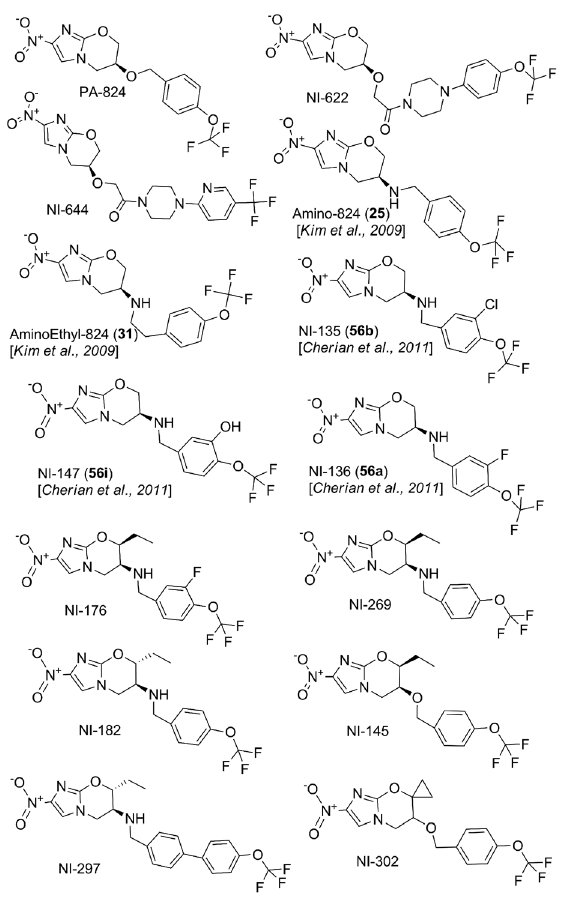
Figure 1. Chemical structures of bicyclic 4-nitroimidazole analogs used in this